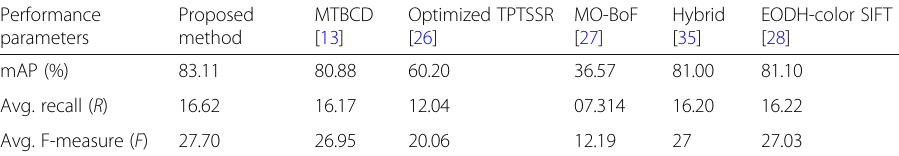
Table 5 Comparative analysis of competitive methods with the proposed method on the Scene 15 dataset